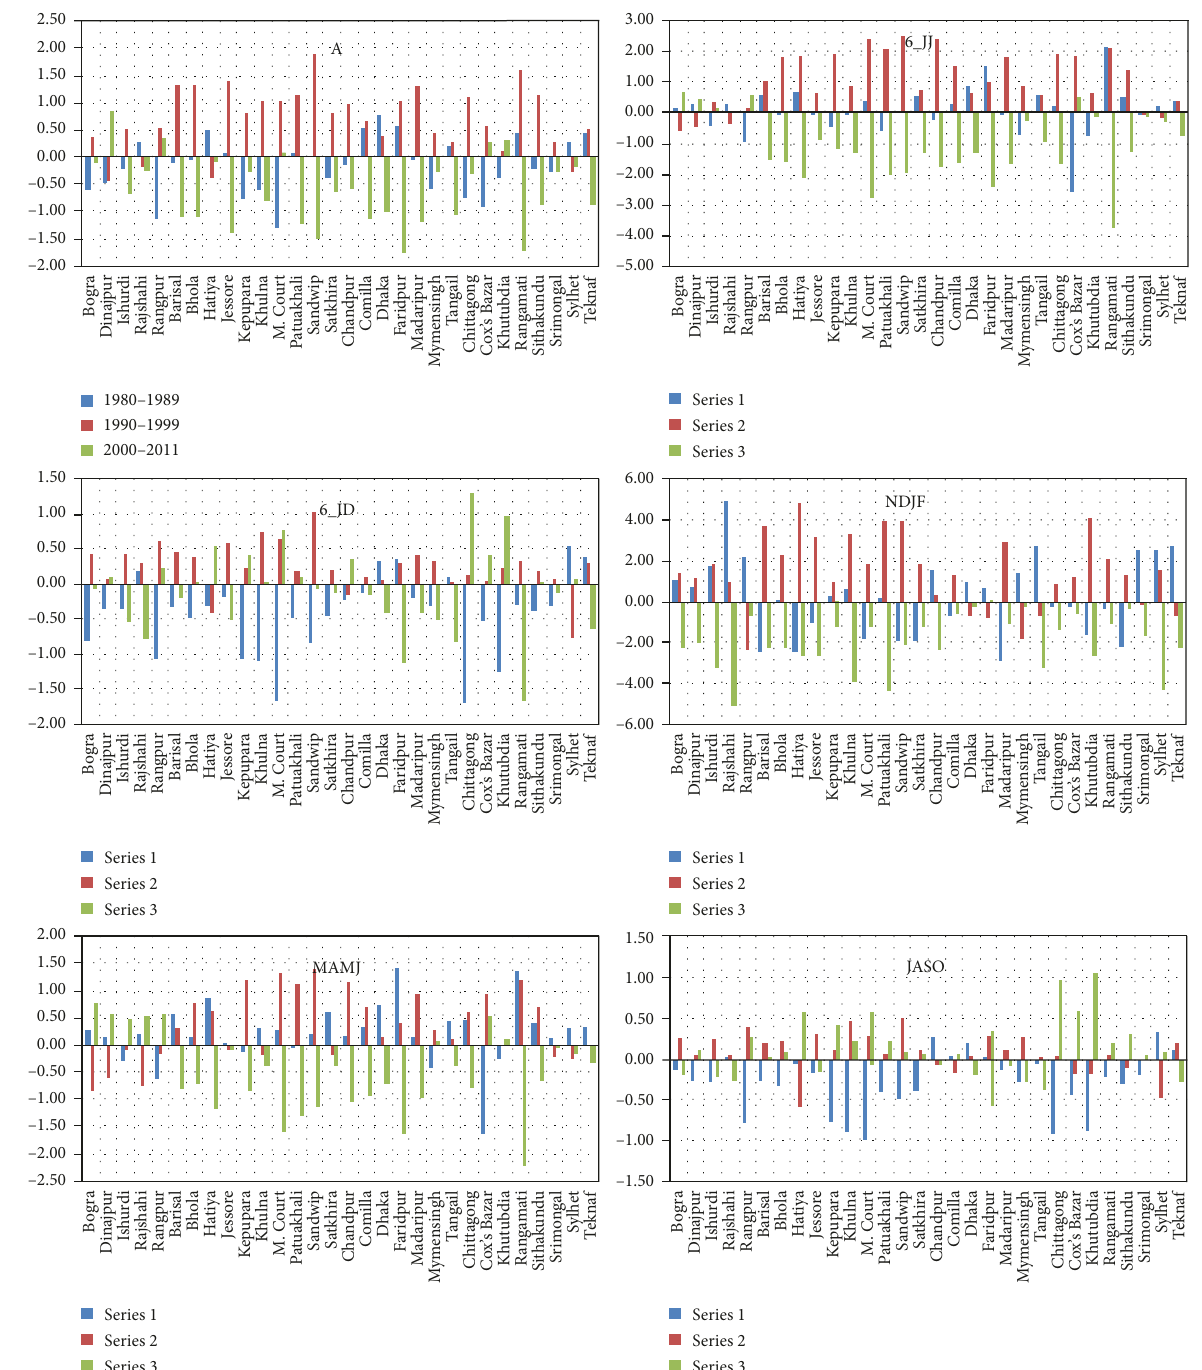
Figure 10: Annual to seasonal PCI changes in different periods from long-term mean PCI (1980–2011) (series 1 1990–1999, and series 3 (cid:31)